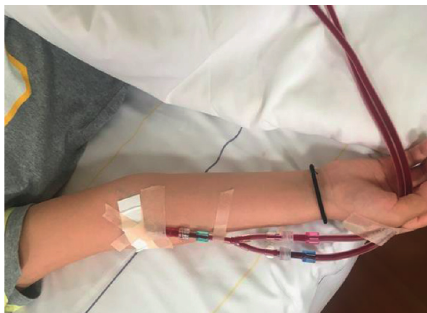
Figure 1: Granulomonocytapheresis with the single-needle method. A 17-gauge dialysis puncture needle (outer diameter: 1.4mm, length: 25mm) is inserted into the right elbow vein.